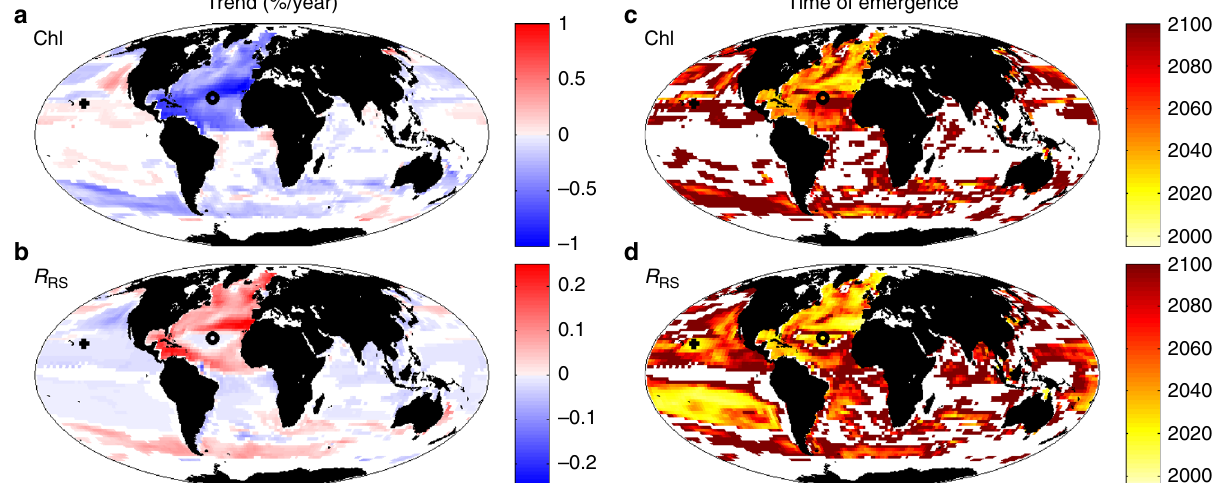
Fig. 9 Trends and time of emergence. Model linear trend (%/year) for a actual Chl-a, and b remotely sensed re fl ectance at 475 nm; and time of emergence of trend for c Chl-a, and d R RS at 475 m. A generalized least squares (GLS) fi t was used to quantify the trends. Only regions with statistically signi fi cant ( p < 0.05) trends over the 21st century and that were largely ice-free in the current day (as model R RS are only valid for such regions) are shown. The symbols ( + ,o) indicate two locations highlighted in Fig.